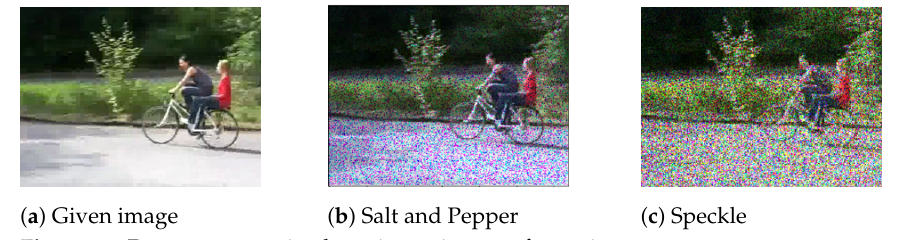
Figure 10. Data augmentation by using noise transformation.